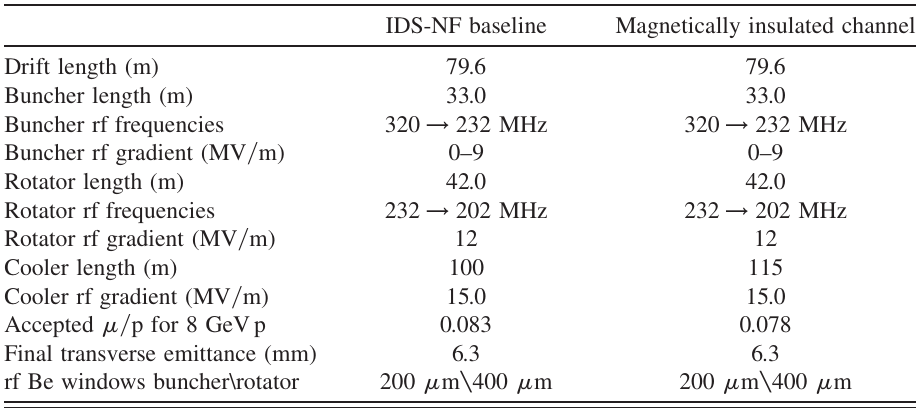
FIG. 8. Simulation results of the performance of a magneti- cally insulated front-end channel (solid line) vs the baseline (dashed line). (a) The muons per incident proton on the target within a transverse acceptance of A T (cid:5) 0 : 03 m and longitudinal acceptance of A L (cid:5) 0 : 15 m , which are the acceptances of the downstream accelerators and storage rings. (b) Normalized transverse rms emittance. TABLE I. Parameters of two front-end scenarios: IDS-NF baseline with pillbox cavities (left) and magnetically insulated channel